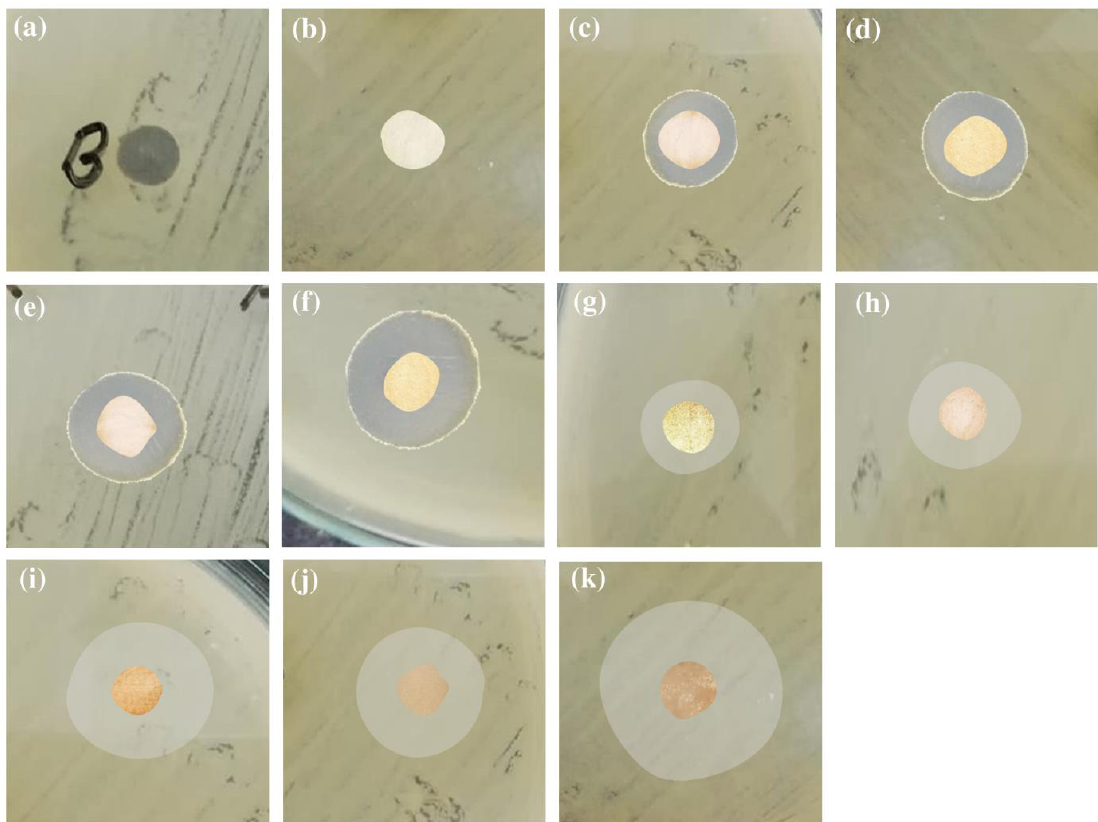
Figure 8. Antibacterial activities against E. coli by: ( a ) blank; ( b ) pristine PVA; ( c ) 3% Ag–NPs(C)–PVA